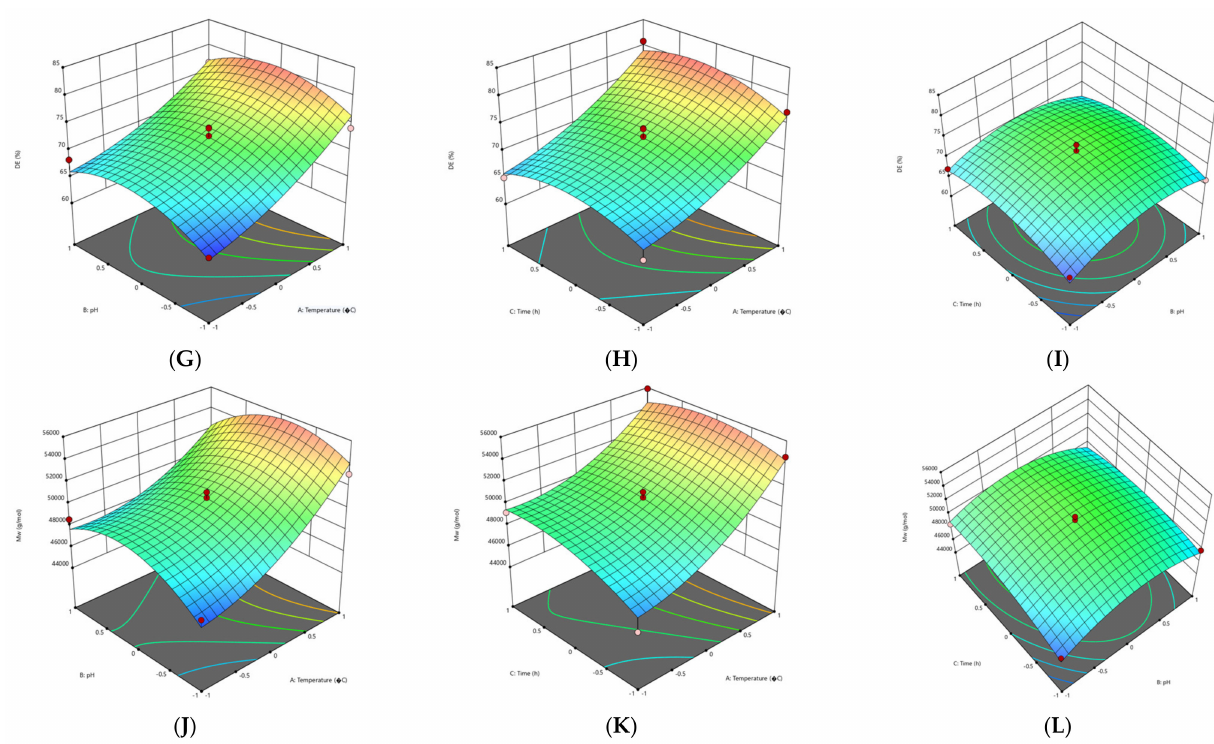
Figure 2. 3D graphs showing the influence of extraction parameters on the yield ( A – C ), GalA content